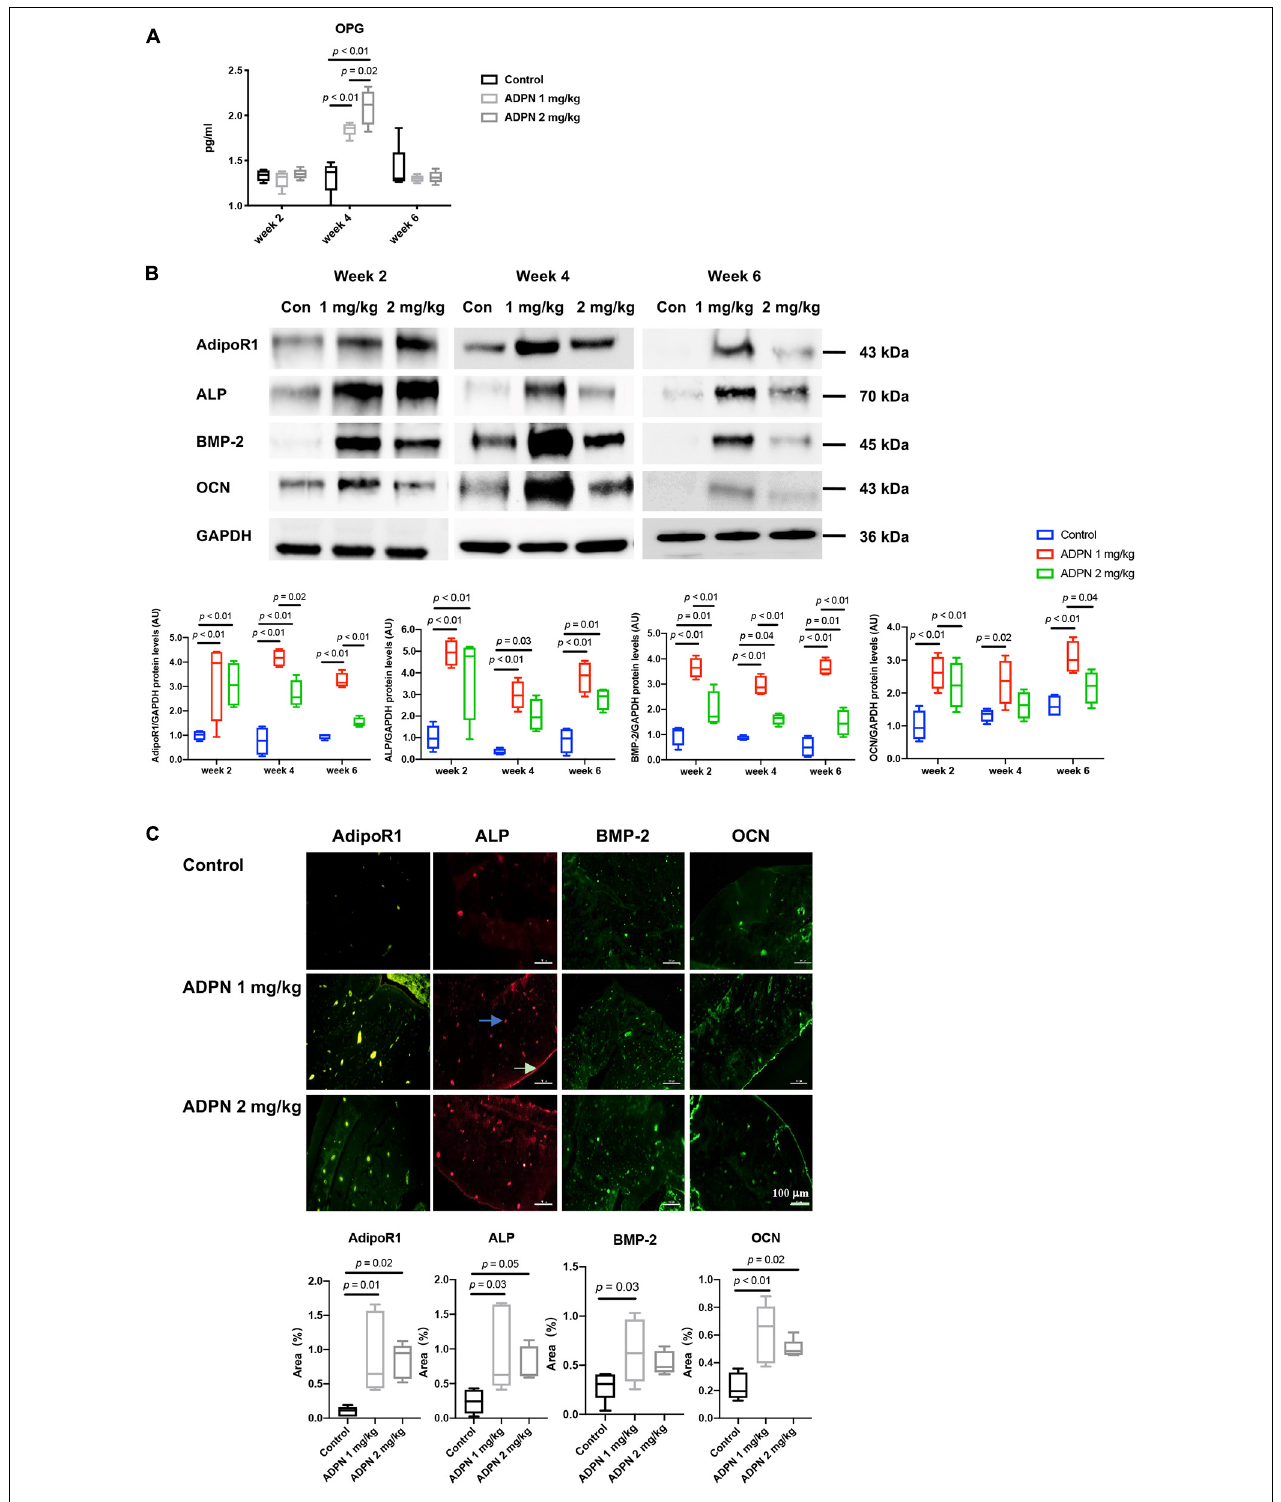
FIGURE 6 | Mechanisms for local medulla injection of ADPN promoting bone healing. (A) Serum Osteoprotegerin (OPG) levels at weeks 2, 4, and 6. (B) WB analysis of alkaline phosphatase (ALP), bone morphogenic protein 2 (BMP-2), osteocalcin (OCN), and adiponectin receptor 1 (AdipoR1) expressions with corresponding quantification, (C) Immunofluorescent staining of ALP, OCN, BMP-2, and AdipoR1 in G2 (ADPN 1 mg/kg) and G3 (ADPN 2 mg/kg), and the corresponding quantification, n = 5. The white arrow indicates the periosteum, and the blue arrow indicates the lacuna, scale bar = 100 µ m.